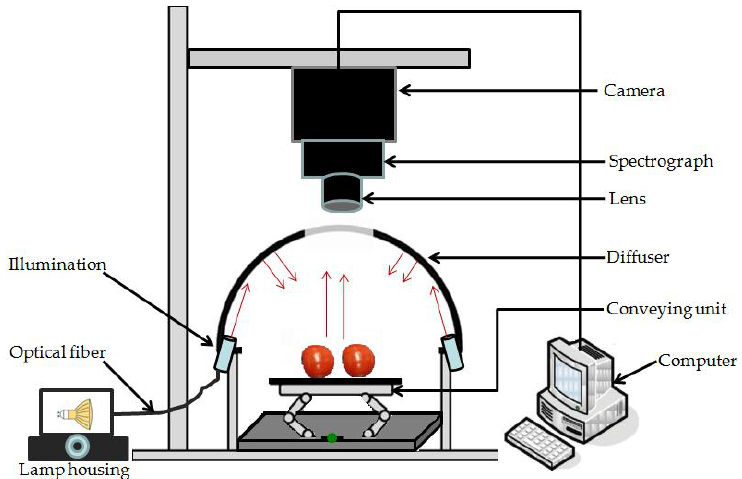
Figure 2. Schematic of the hyperspectral imaging system.